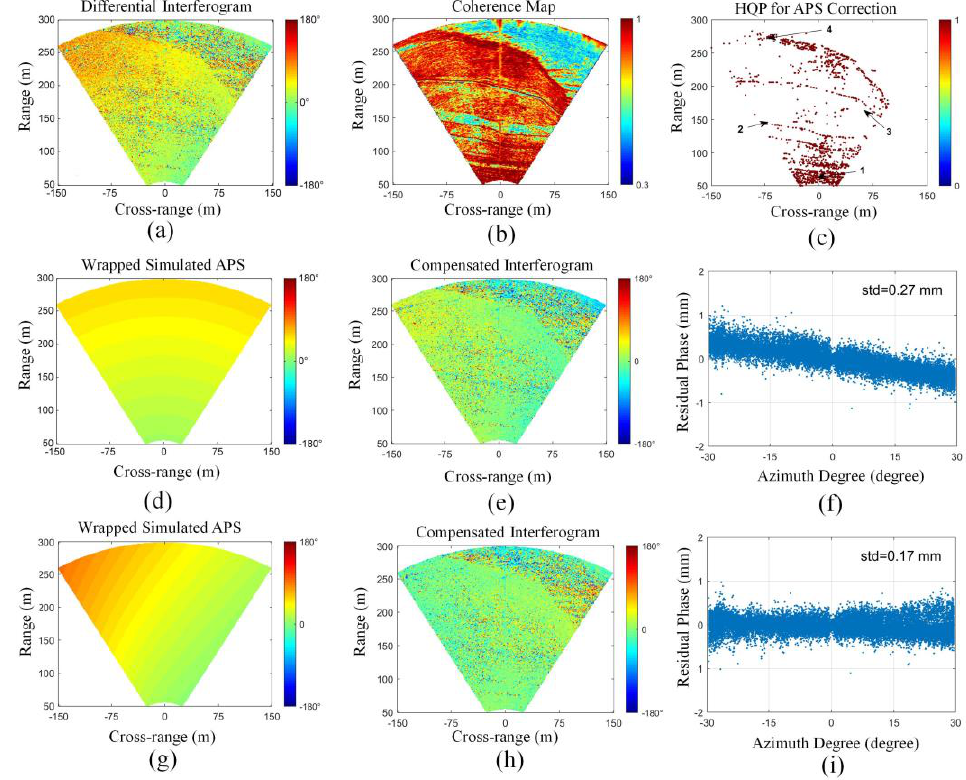
Figure 6. The validation experiment for the 2D observation scenario in the Linjiaping railway slope. ( a ) The differential interferogram, ( b ) the coherence image, and ( c ) the selected high-quality points for APS correction. ( d – f ) are the wrapped simulated APS, the compensated interferogram, and the residual phase (compensated phase) along the azimuth direction of the range-related model, and ( g – i ) are those of the 2D model. The APS simulated by the 2D model is more consistent with the phase in the interferogram. The residual phase ( i ) also shows the higher accuracy of the 2D model, since the standard deviation is smaller than that ( f ) of the range-related model and neither over- nor under-correction occurs.